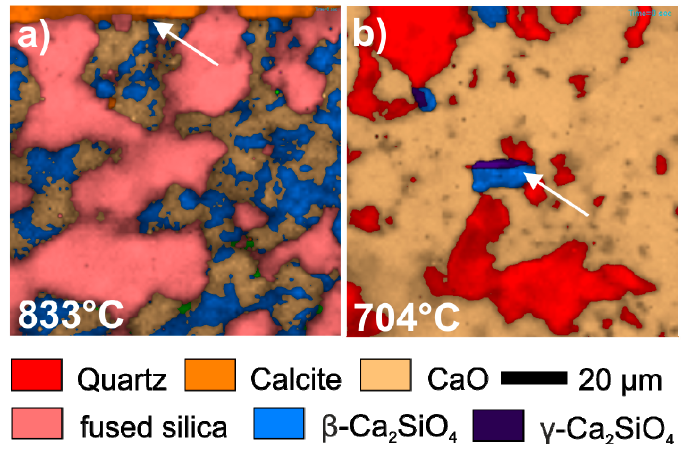
Figure 2. Hyperspectral Raman images of ( a ) fused silica-calcite and ( b ) quartz-lime green bodies recorded at 833 and 704 °C with a total exposure time of about 2 h, showing line-by-line image shifts. The sudden phase changes (white arrows) indicate that the respective reactions in (a), i.e., CaCO 3 → CaO + CO 2 ↑ , and (b), i.e., γ -Ca 2 SiO 4 → β -Ca 2 SiO 4 , were faster than the total imaging time.